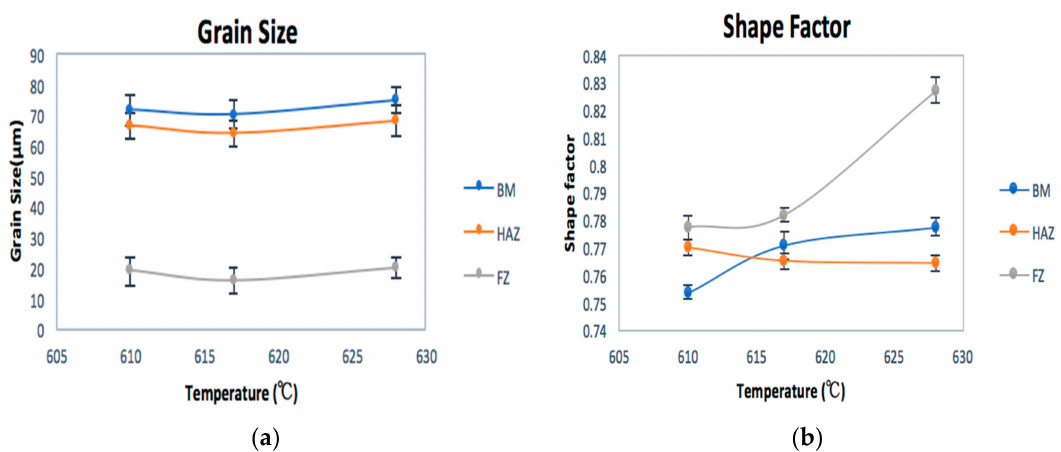
Figure 9. ( a ) Graph of grain size against temperature, ( b ) Plot of shape factor as a function of the three temperatures used, 610, 617, and 628 ◦ C for Al 7075 alloy EB welded plates after heat